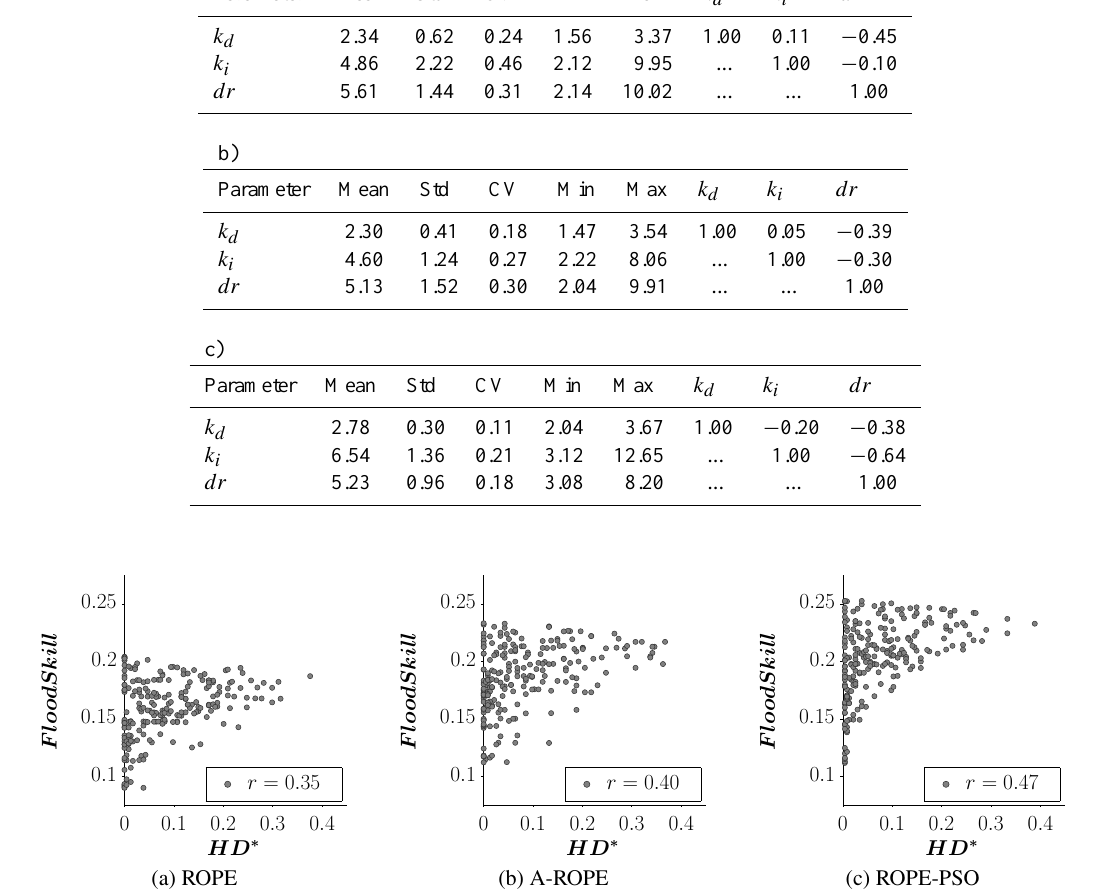
Fig. 9: Correlation between data depth and overall validation performance for the solutions estimated by ROPE, A-ROPE and ROPE-PSO.